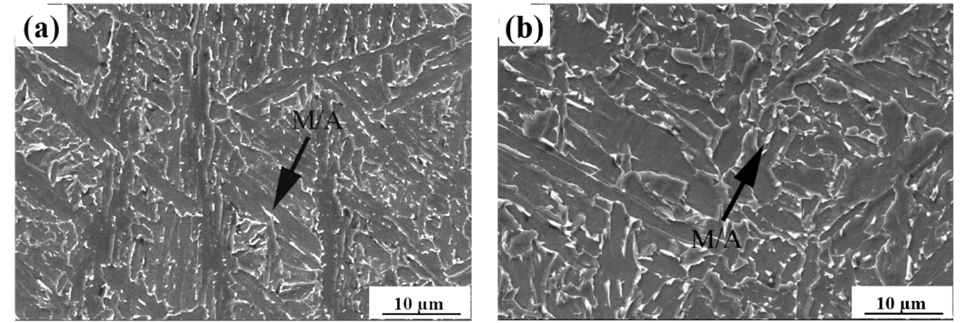
Figure 3. SEM images of simulated CGHAZ with a heat input of 20 kJ/cm in the steels containing. ( a ) 0.073%, ( b ) 0.110% Nb.